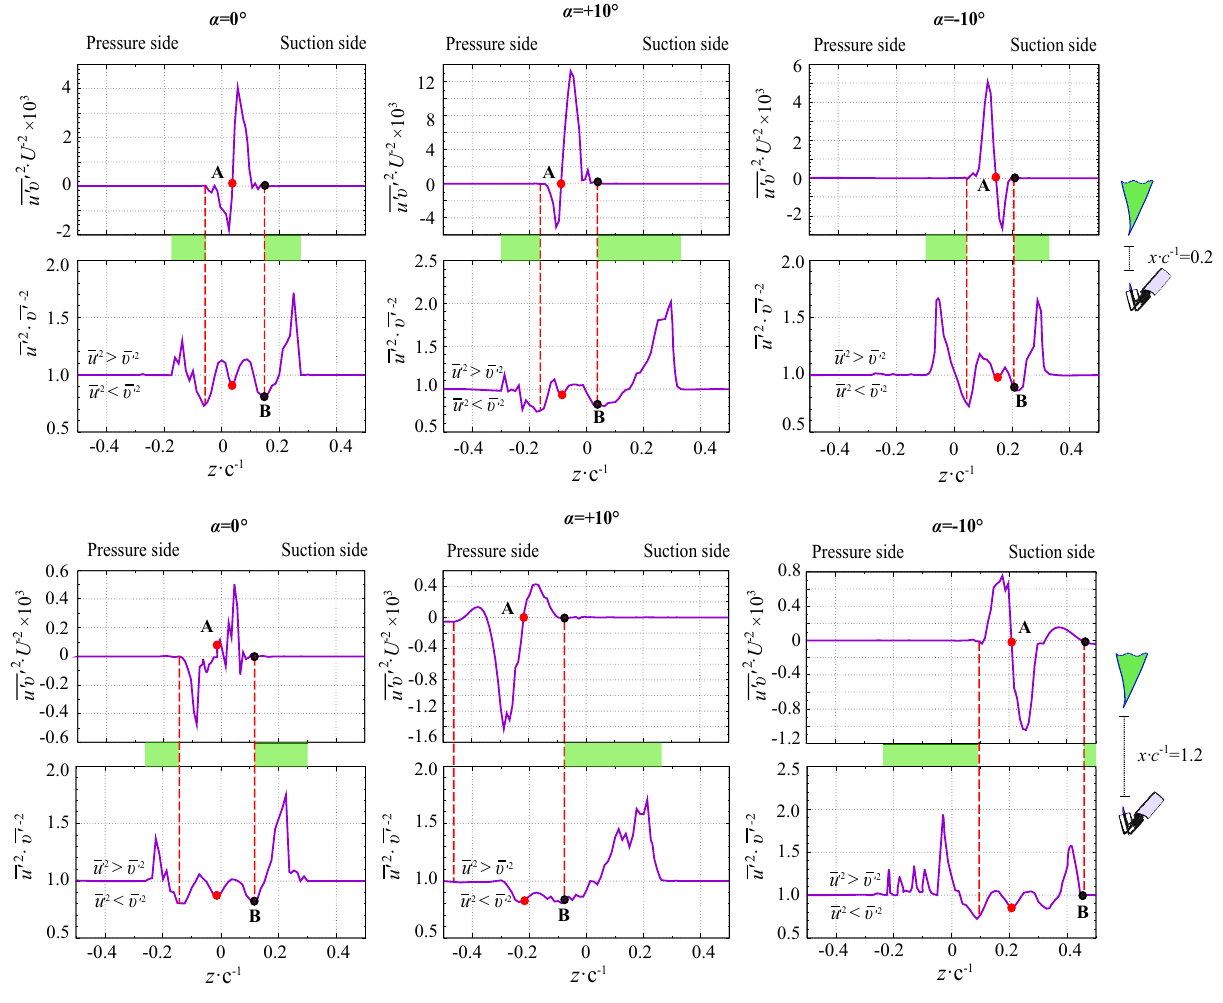
line. While green indicates the range of the shear layer. A and B are characteristic points of the turbulent